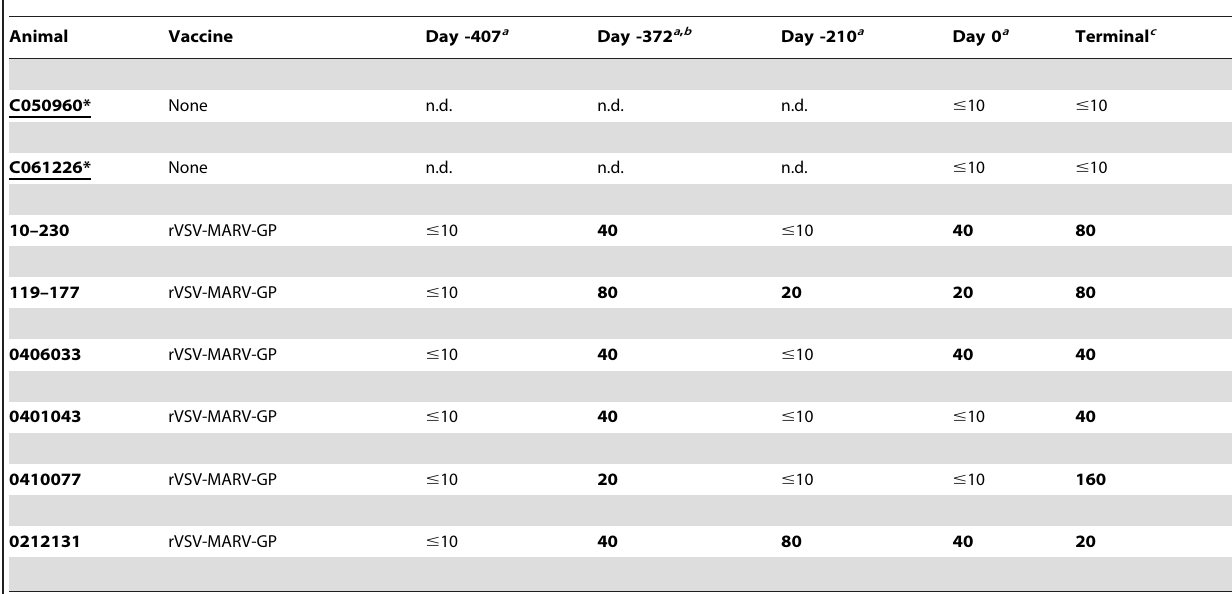
Table 1. Reciprocal MARV GP serum neutralizing antibody titers at which 50% of rVSV-MARV-GP was neutralized.